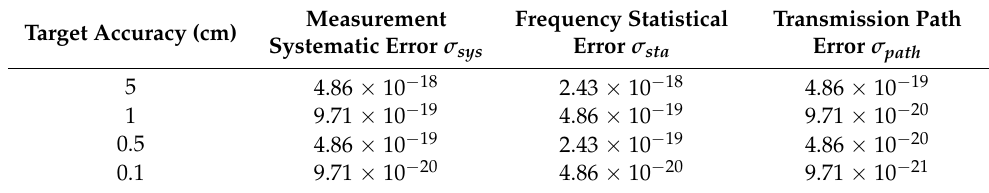
Table 6. Requirements for measurement systematic error σ sys and frequency statistical error σ sta of a pair of optical clocks and transmission path error σ path under different target